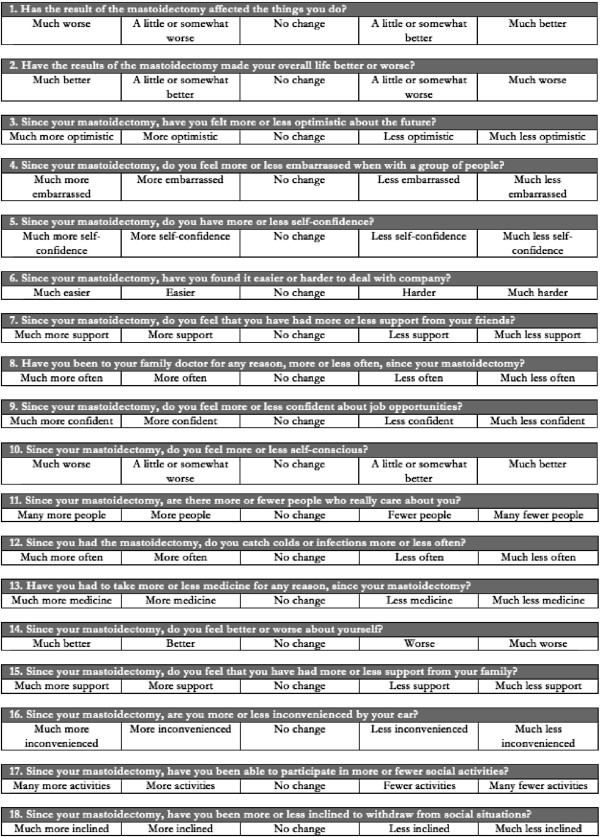
GBI questionnaire.